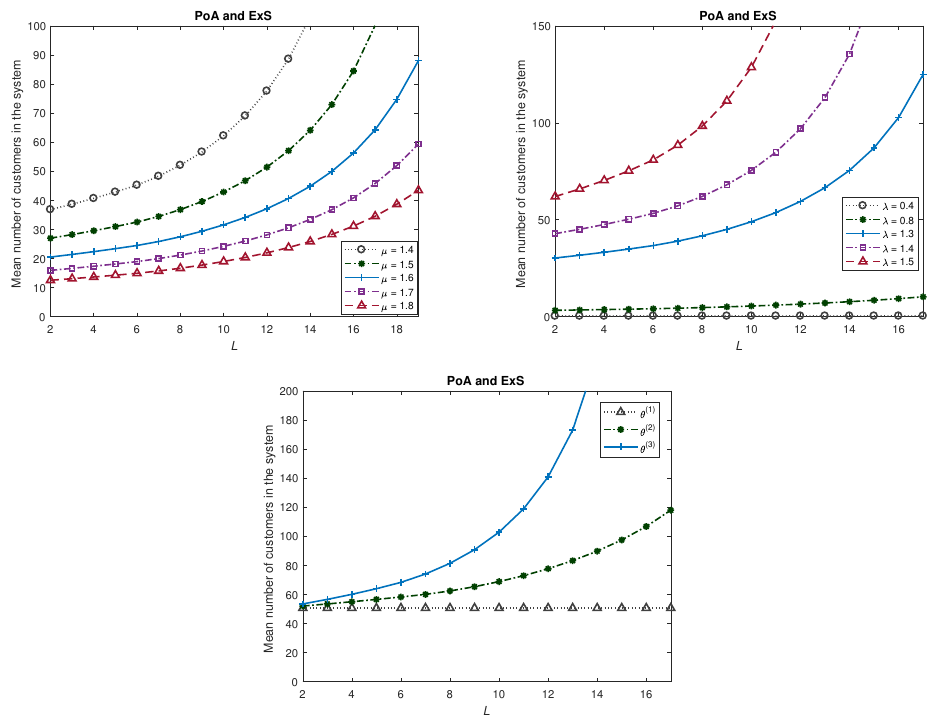
Figure 1. Mean number of customers in the system (Model